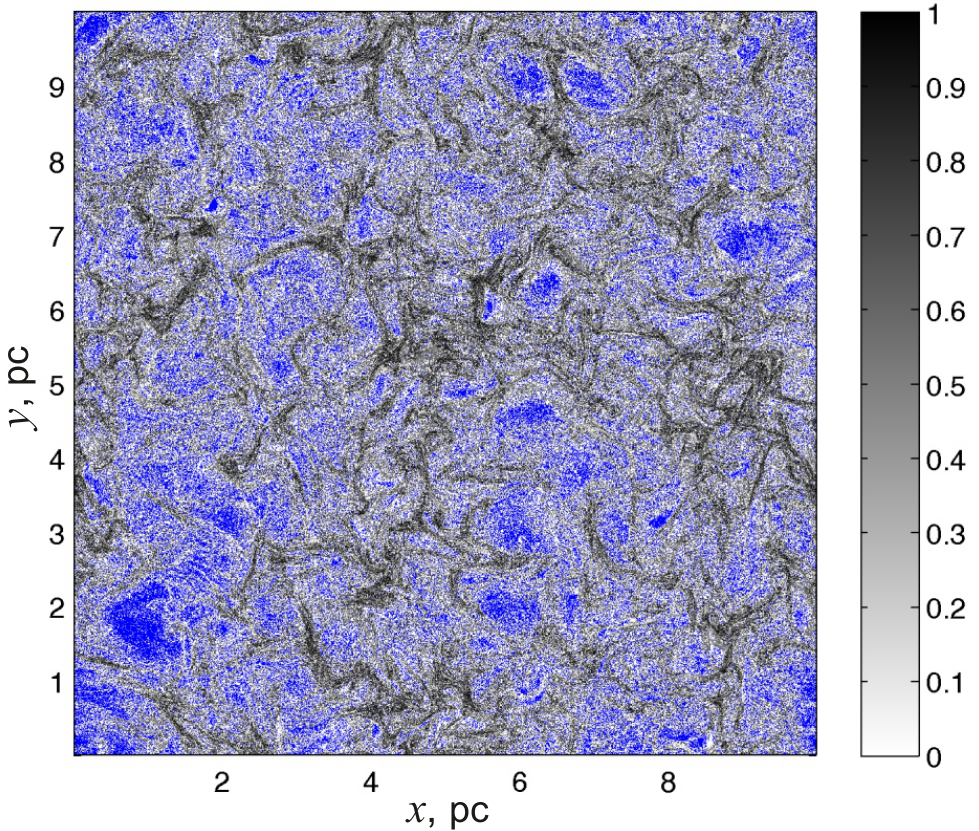
Figure 4. The entropy distribution of a mixture of three fractions of dust particles at the same time as in Figures 2 and 3. The black color corresponds to a homogeneous polydisperse mixture, and white is a monodisperse mixture, while the areas free of dust particles are highlighted in